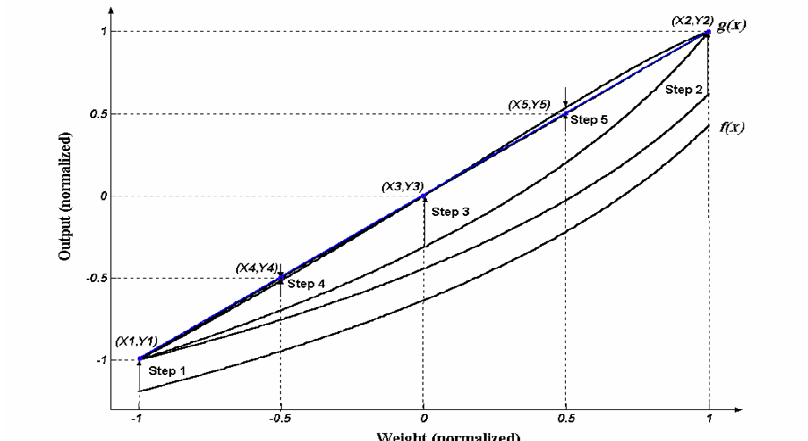
Figure 3. Successive correction curves of a strain gauge.